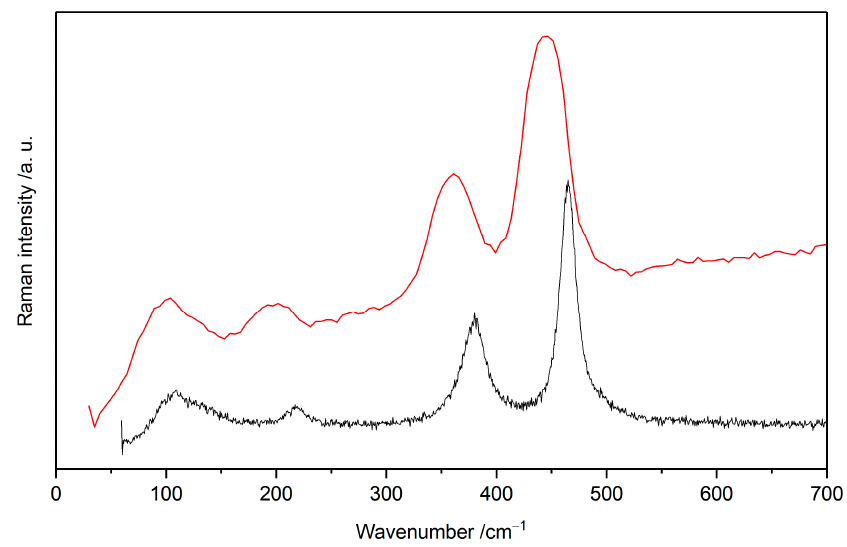
Figure 4. Raman spectrum measured at room temperature (red) and 123 K